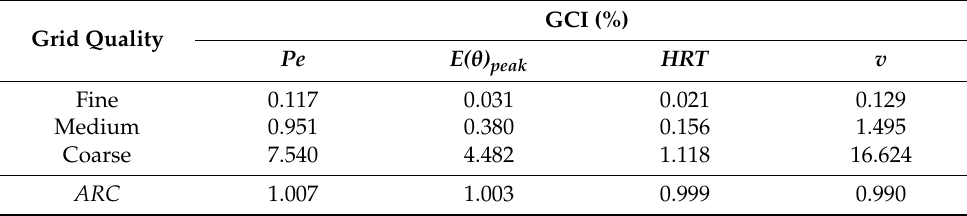
Table 4. Grid convergence